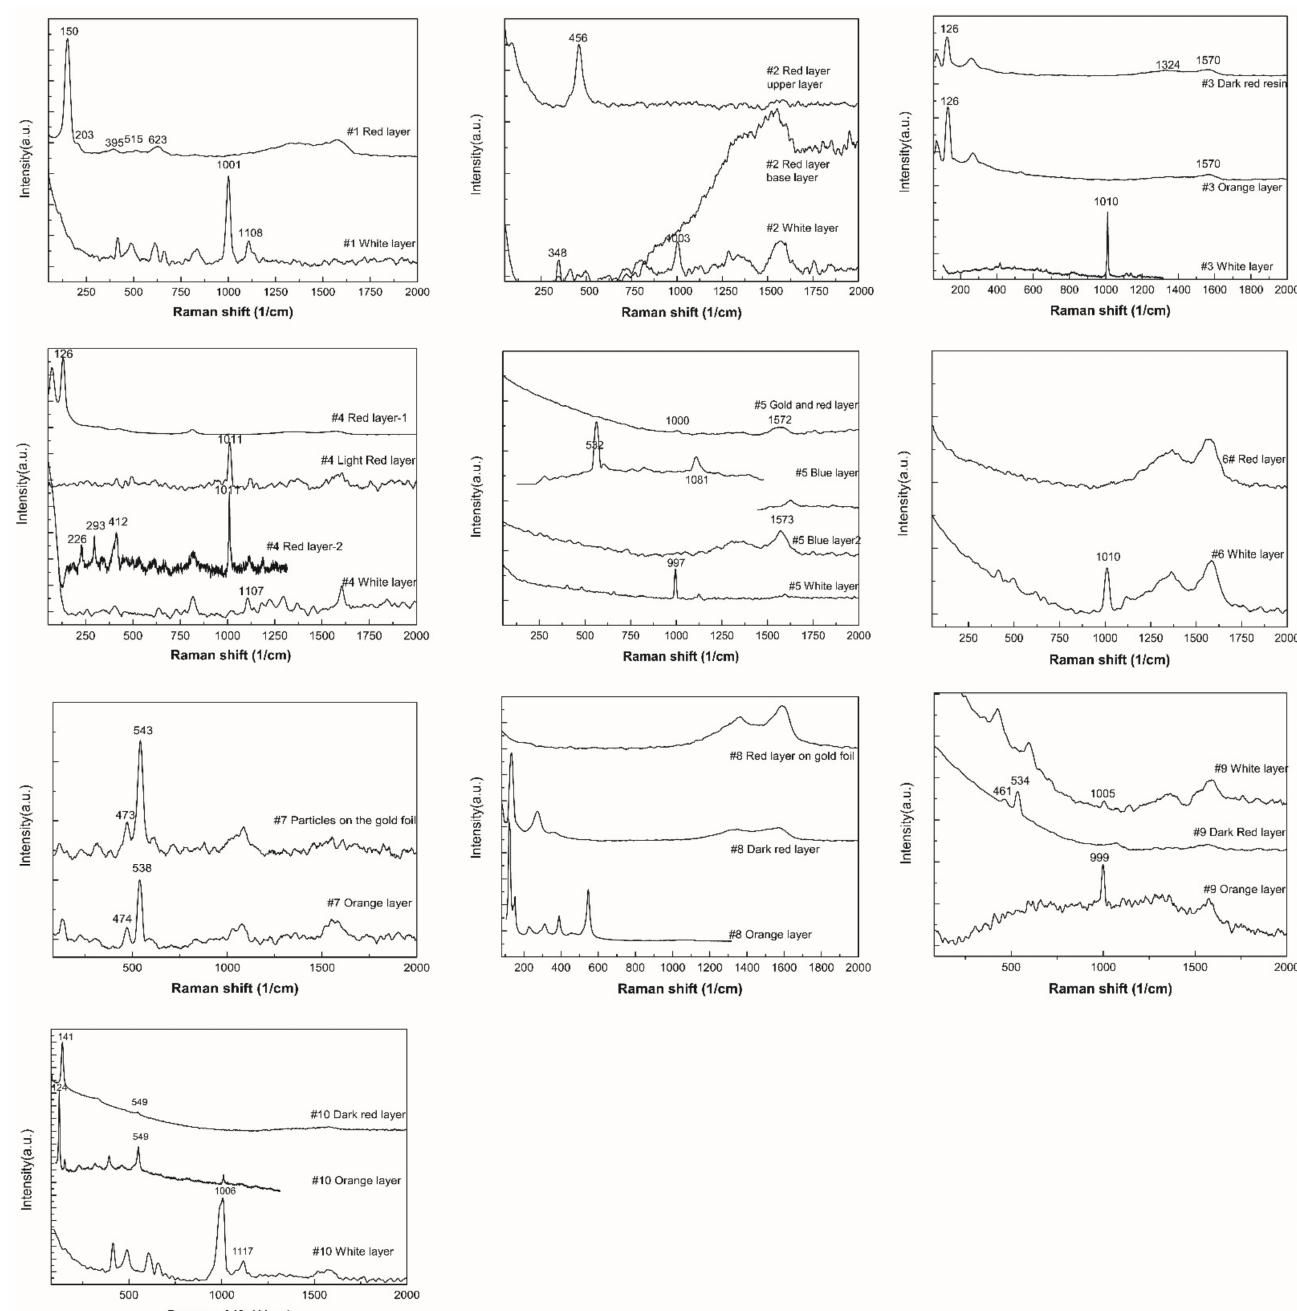
Figure A2. The Raman spectra of each sample